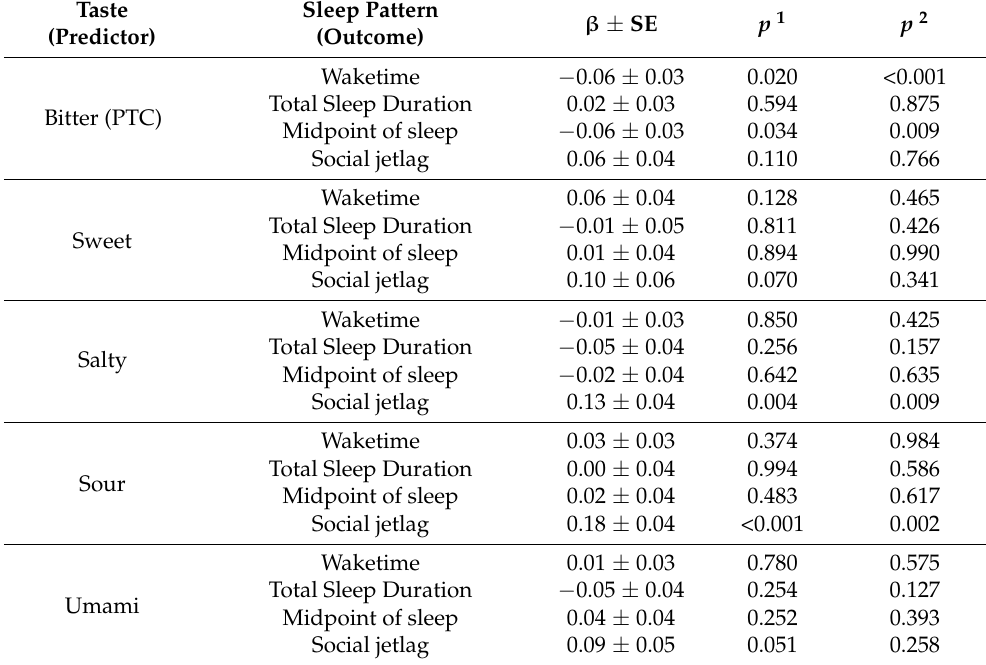
Table 6. Associations between phenotypic taste perception and sleep